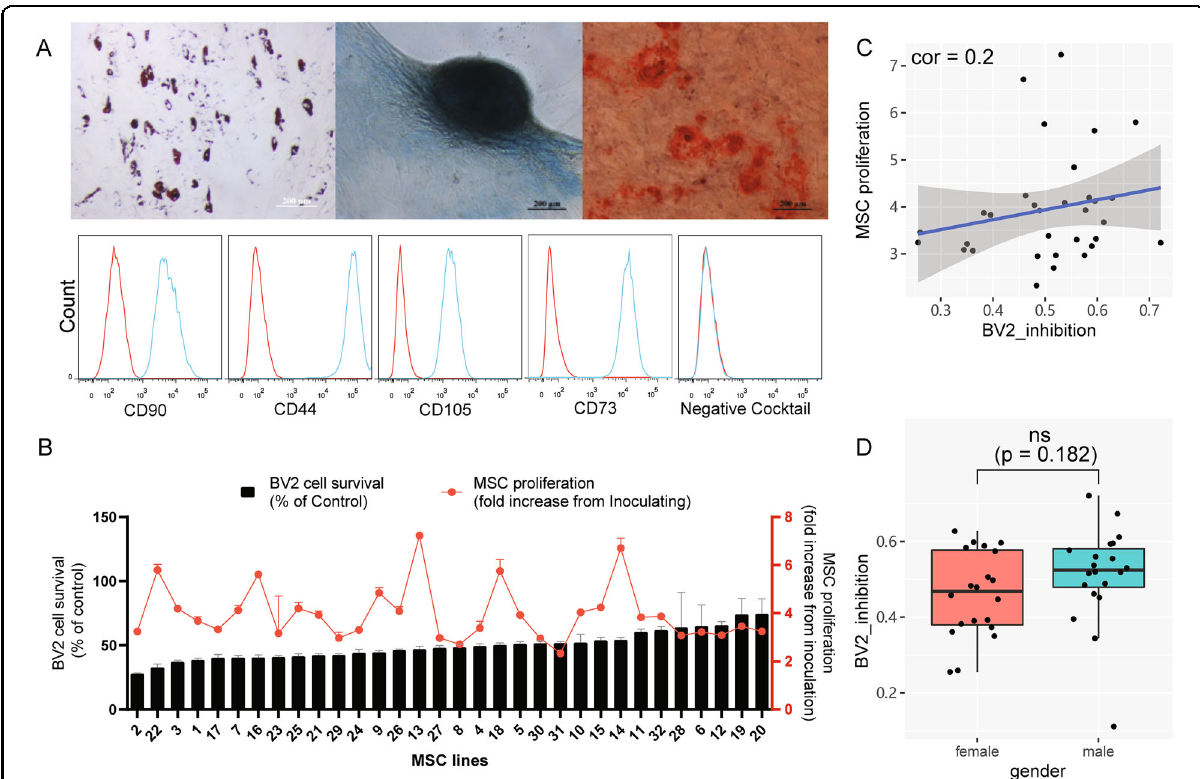
Fig. 1 Donor-dependent variations of huMSC proliferation and immune modulation. A Three lineage differentiation of huMSCs and expression of cell surface markers. Upper Panel from left to right: MSCs differentiated to adipocytes, chondrocytes, and osteocytes. B BV2-suppression capacity and proliferation capacity of 32 lines of huMSCs. The black bars represent the ratio of BV2 cell mass after 48 h cultured in MSC-CM compared to RPMI- 1640 (control medium). The red dots represent the ratio of total huMSC mass at 72 h after inoculation compared to 1 h after inoculation. C correlation between BV2-suppression capacity and huMSC proliferation capacity of 32 huMSC lines. D Boxplot shows BV2-suppression capacity between male ( n = 20) and female ( n = 20) huMSC lines, eight extra huMSC lines were added to increase the statistical